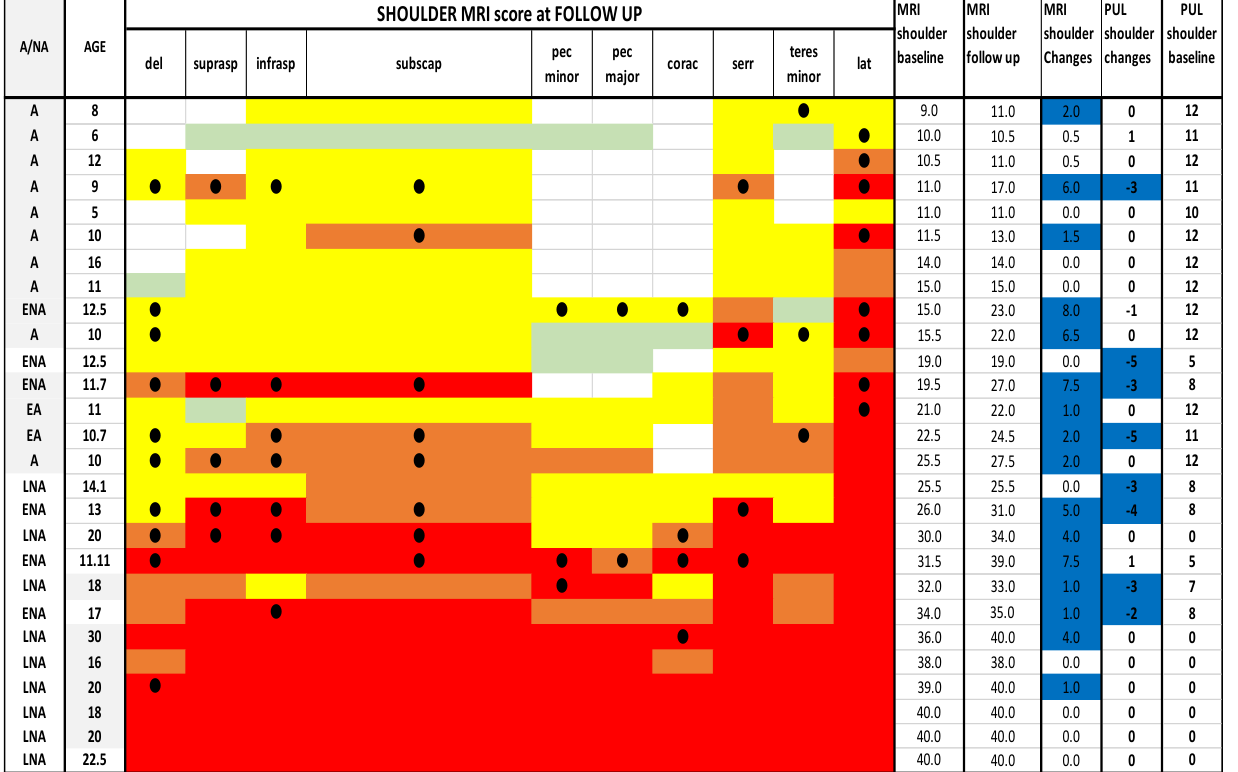
Figure 5. Detail of MRI and PUL at shoulder level. Individual details of imaging and PUL findings at shoulder level. The shading reflects the severity of involvement with the score of 0 shown as a white cell, score of 1 as pale green, score of 2 as yellow, score of 3 as orange and score of 4 as red. The grade 2.5 was used to identify patients with 2b involvement. Del = deltoid; suprasp = supraspinatus; infrasp = infraspinatus; subscap = subscapularis; pec = pectoralis; corac = coraco- brachialis; serr = serratus anterior; lat = latissimus dorsi; A= ambulant; EA = early ambulant; NA= non ambulant; ENA = early non ambulant; LNA: late non ambulant. ● Black circle means a higher Mercuri score respect to the baseline in the respective muscle. Blue line indicates changes in both MRI and PUL scores.